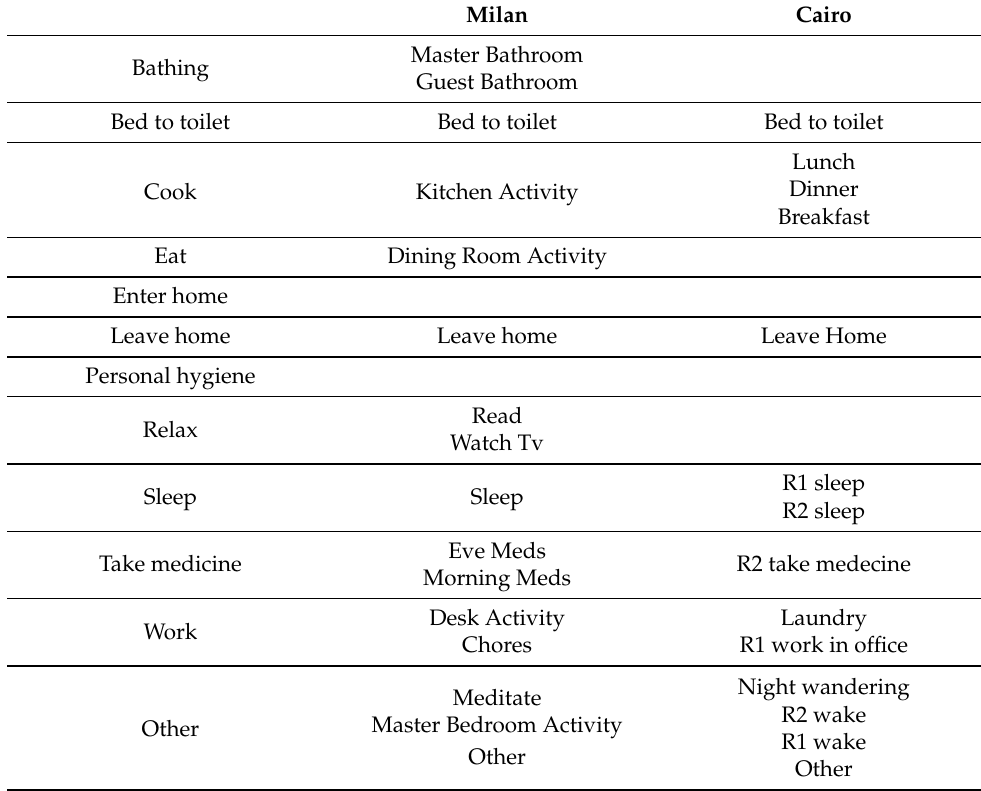
Table 2. New activity